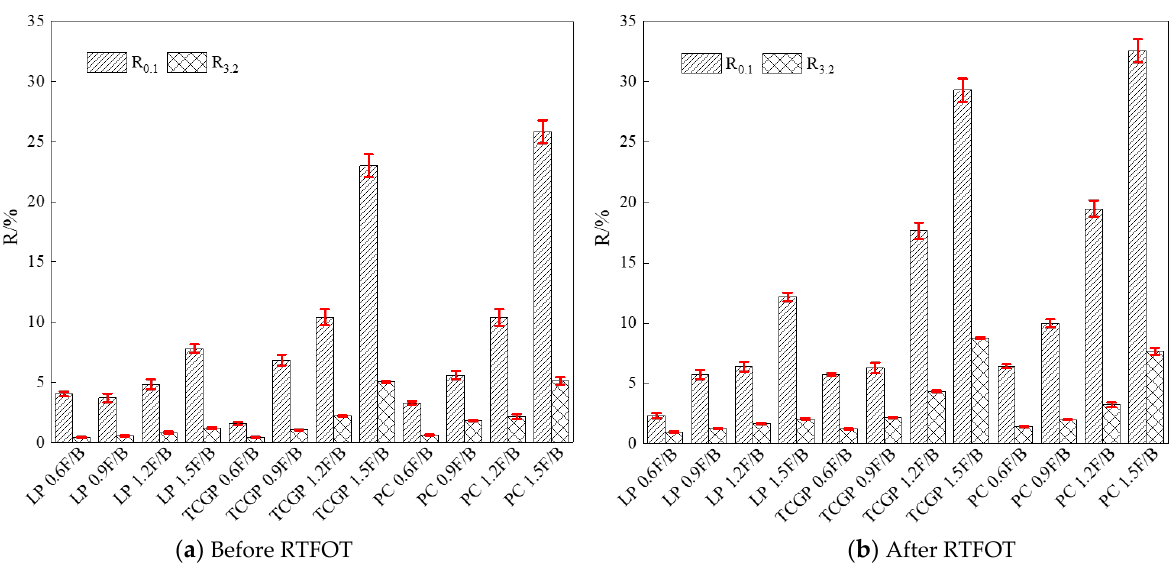
Figure 14. Test results of R of different emulsified asphalt mastics (70 ℃ ).